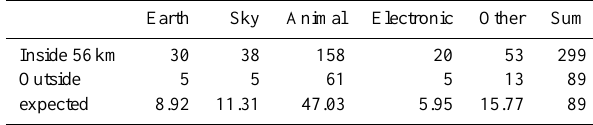
Table 2. Chi-squared test for events inside and outside